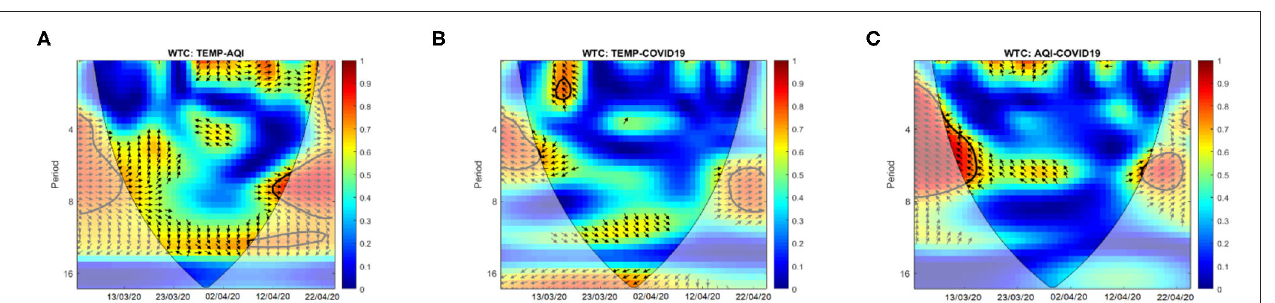
Frontiers in Public Health |